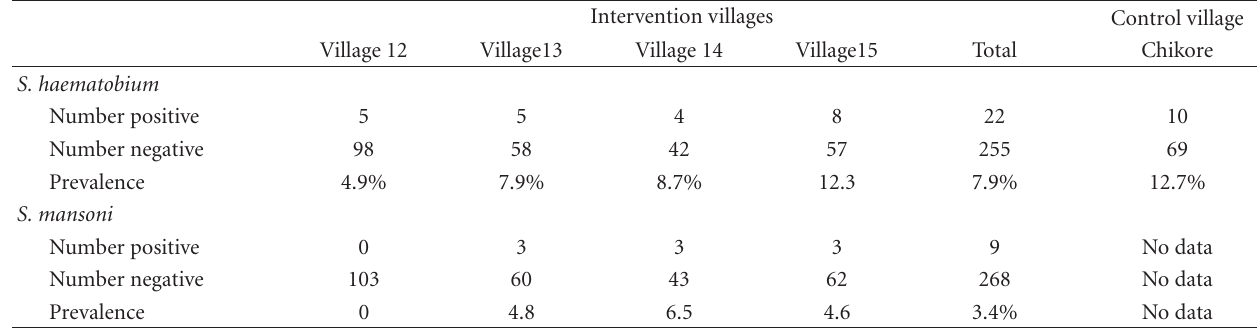
Table 2: Showing the prevalence of S. haematobium in the study population [16]. Intervention villages Control village Village 12